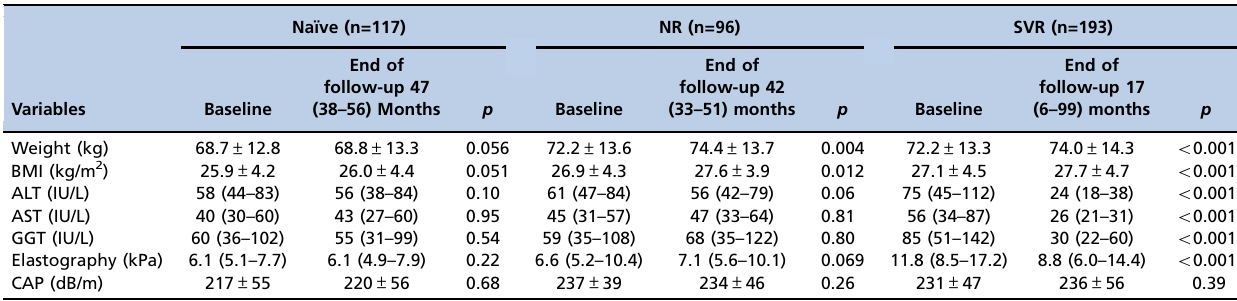
Table 2 - Comparative analysis of the naı¨ve, NR, and SVR HCV-infected patients at baseline and at end of follow-up (n=406).